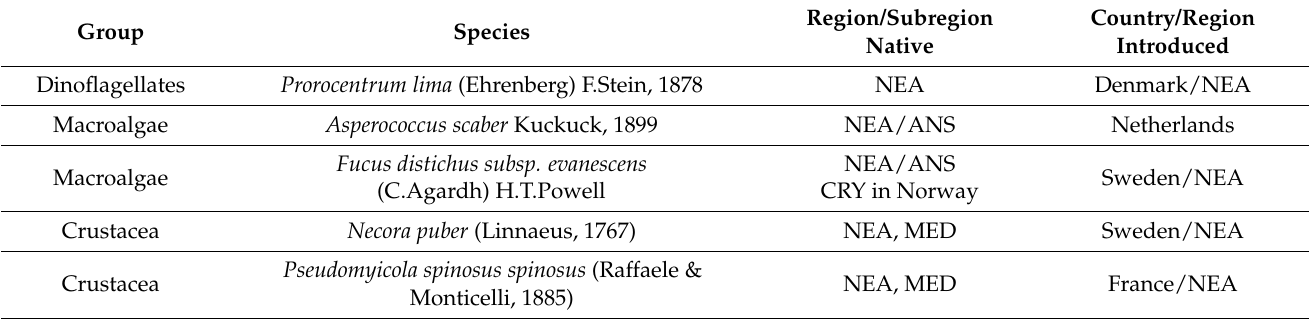
Table 3. Examples of partly native/cryptogenic species within the same region/subregion excluded from the analyses. For regions/subregions’ abbreviations see Table